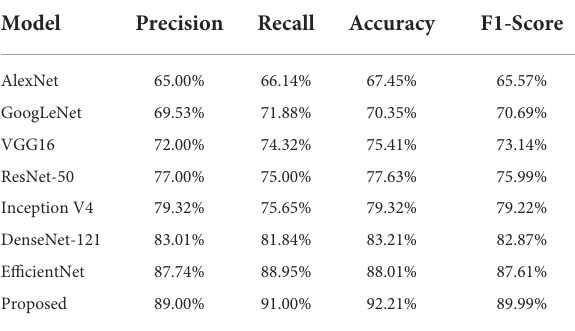
TABLE 4 Comparative comparison with base